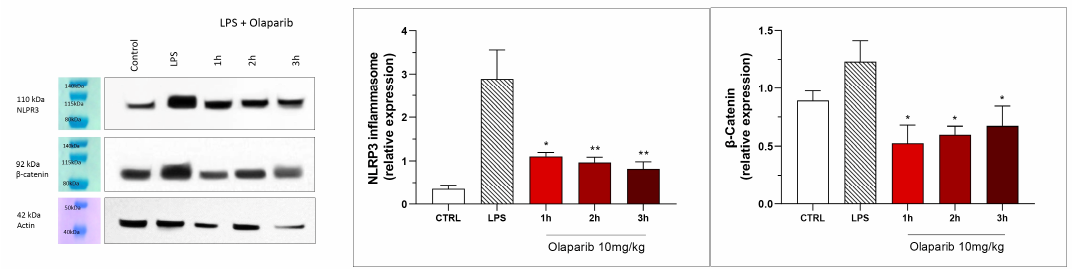
Figure 22. Effect of olaparib post-treatment on NF-κB, caspase 3, ERK2/ERK1, and pAKT/AKT levels in the lung tissue in a murine model of ALI. C57Bl/6 mice received either PBS (30 µL) or LPS (50 µg in 30 µL PBS) by intratracheal instillation in the absence or presence of 10 mg/kg olaparib, delayed to 1, 2, or 3 h post-LPS. After 24 h, lungs were collected, and NF-κB (65 kDa) and caspase 3 levels, ERK1/ERK2 ratio, and pAKT/AKT ratio were measured by Western blotting. * p < 0.05 and ** p < 0.01 indicate inhibitory effects of olaparib on the various parameters in LPS-treated animals. Data are shown as mean ± SEM, n = 8–12/group.